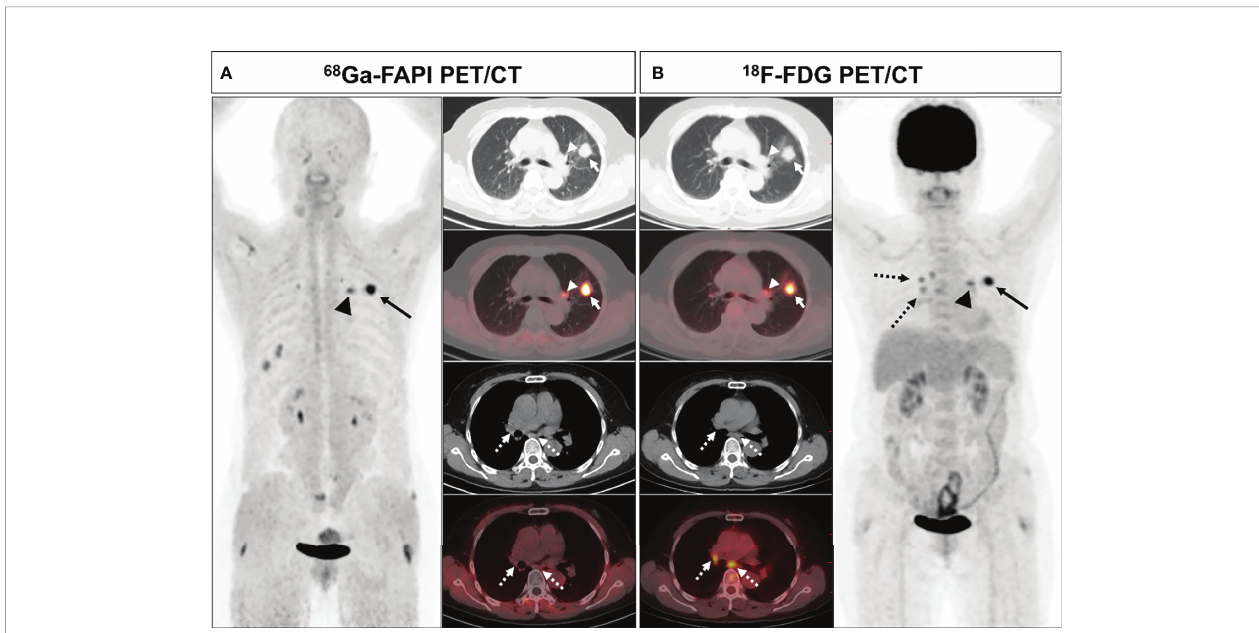
FIGURE 6 | A 61-year-old female (patient 23) diagnosed with adenocarcinoma. 68 Ga-FAPI PET/CT (A) revealed intense FAPI uptake in the primary tumor (solid arrows, SUVmax = 9.7) along with moderately increased uptake in the left pulmonary hilar lymph node (arrows, SUVmax = 5.0), whereas there was no FAPI uptake in the subcarinal and right pulmonary hilar lymph nodes (dashed arrows). 18 F-FDG PET/CT (B) demonstrated intense FDG uptake in the primary tumor (solid arrows, SUVmax = 9.0) with moderate uptake in the left pulmonary hilar (arrows, SUVmax = 4.5), subcarinal, and right pulmonary hilar (dashed arrows, SUVmax = 3.5) lymph nodes. Pathological biopsy con fi rmed metastasis in the left hilar lymph node, while no metastasis was found in the subcardiac or right hilar lymph nodes.